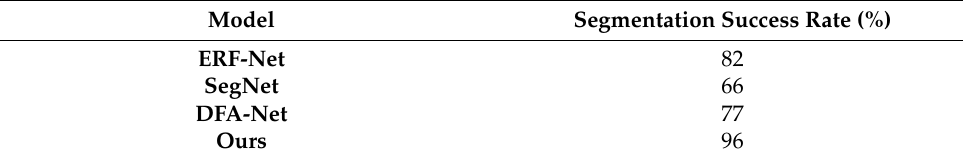
Figure 12. Extracted fringe centers and fitted straight lines: ( a , b ) segmentation succeeded and ( c , d ) segmentation failed. Table 9. Network segmentation success rate.